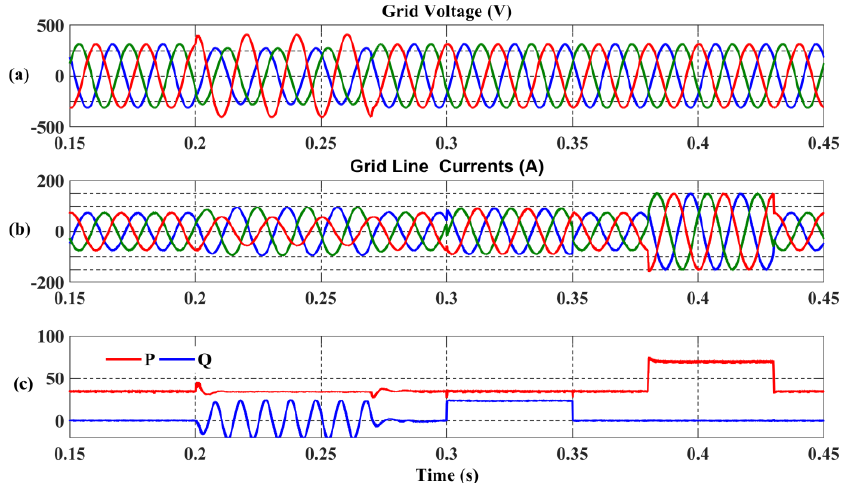
Figure 11. Simulation C results with external P ss2 -P sc2 controllers: ( a ) grid voltage (V) (red: phase-A, blue: phase-B, green: phase-C); ( b ) grid currents (A) (red: phase-A, blue: phase-B, green: phase-C); and ( c ) P g (kW) and Q g (kVAr).